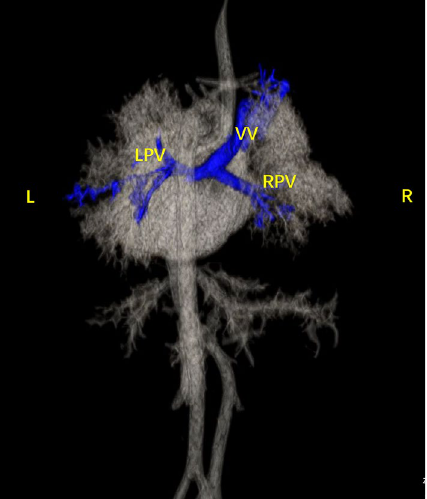
Figure 7. Postpartum CTA findings. The left and right PVs converged to form a PV trunk and returned to the right superior vena cava via the vertical vein.